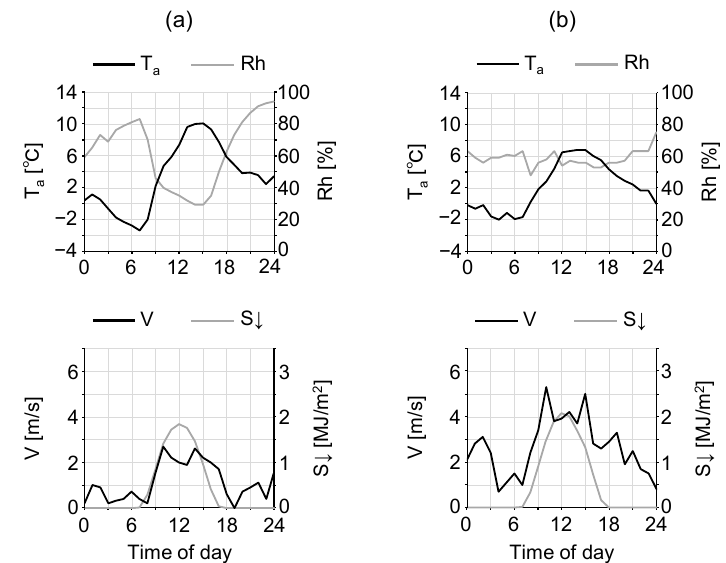
Figure 2. Meteorological conditions of the observation days derived by AMeDAS Tsuchiura site (air temperature (T a ) and wind velocity (V)) and AMeDAS Tsukuba site (relative humidity (Rh) and downward short-wave radiation (S ↓ )): ( a ) remote sensing and ( b ) mobile observations.